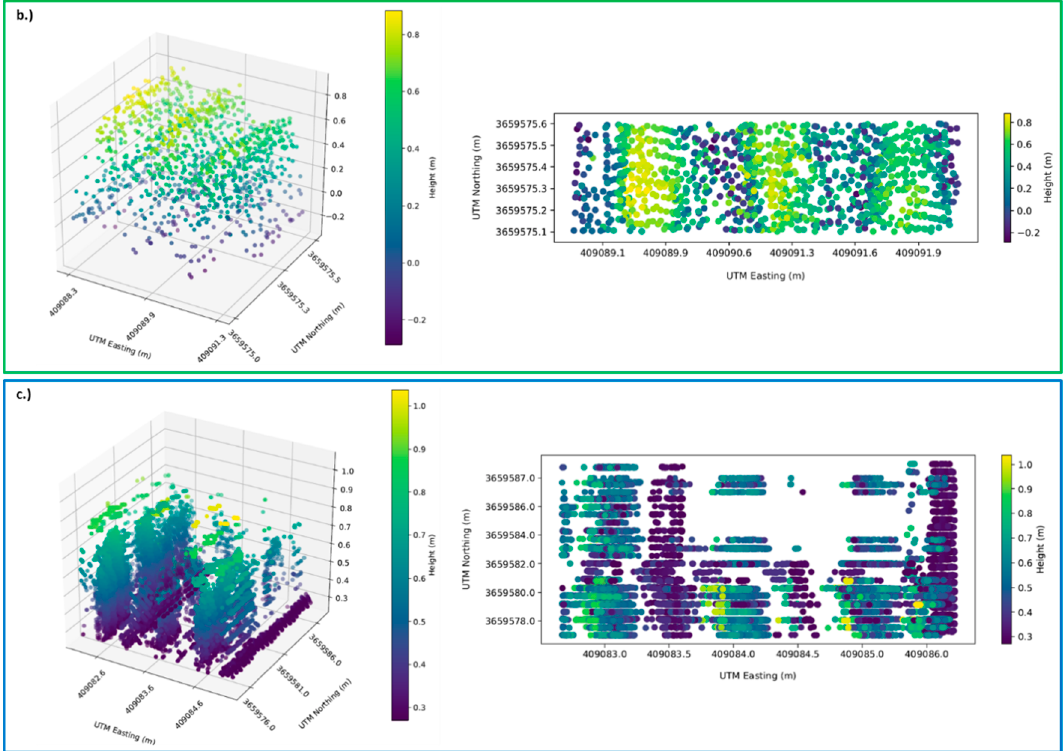
Figure 4. Flow chart for multi-angle view sensors (UAS and LMS511) data processing. The green boxes and arrows depict steps unique to the UAS and blue, steps unique to the LMS511 ( a ). Example outputs (3-D cloud and 2-D cross section) of raw plant heights georeferenced by the UTM coordinates from the 2017 DOY191 UAS collection ( b ) and plants heights before bed height interpolation from the 2017 DOY191 LMS511 collection ( c ).